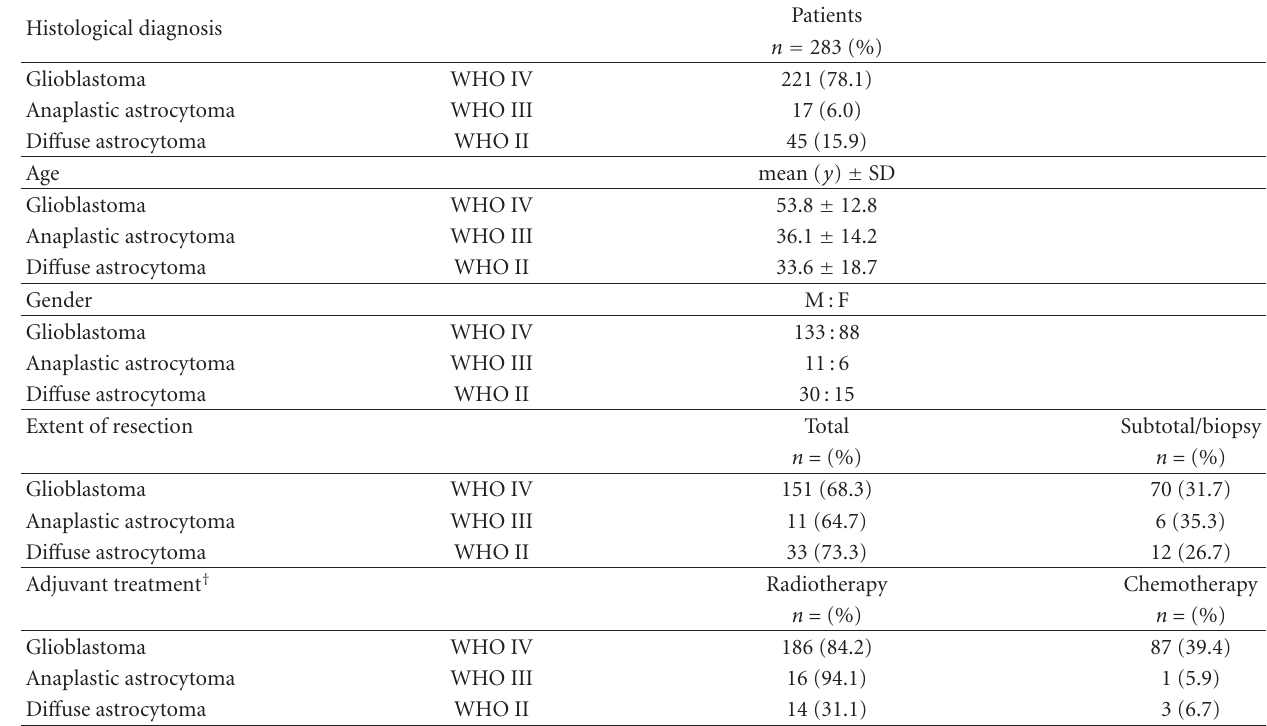
Table 2: Clinicopathological characteristics of patients included in TMA